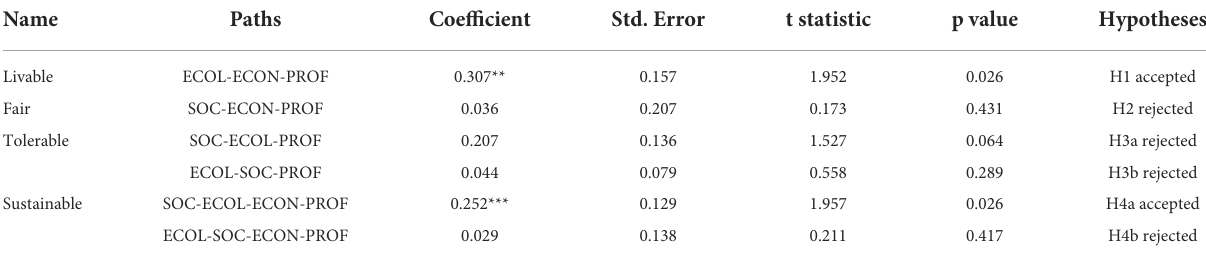
TABLE 7 Total, direct, and indirect effects of the path models related to SD and